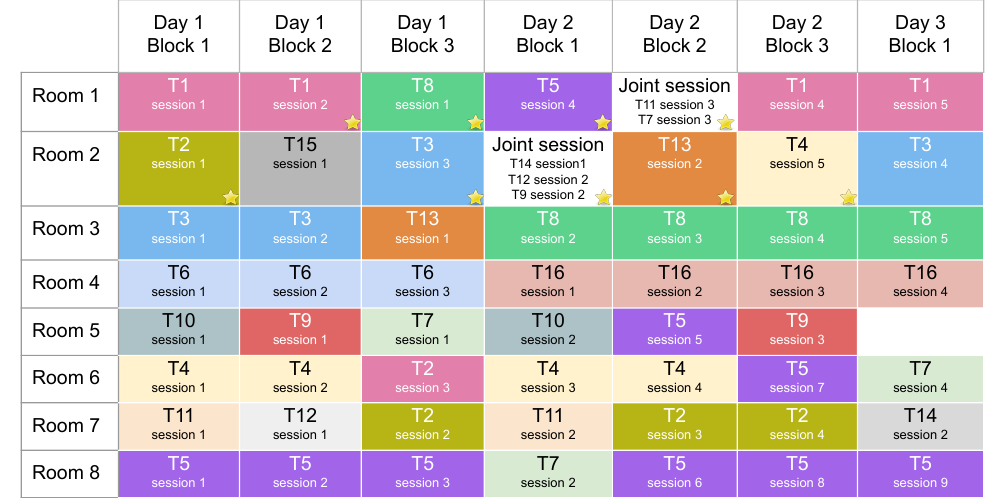
Figure 2. Overview of the conference program of GECCO 2019. Sessions that include best paper nominee talks are marked with a star in the